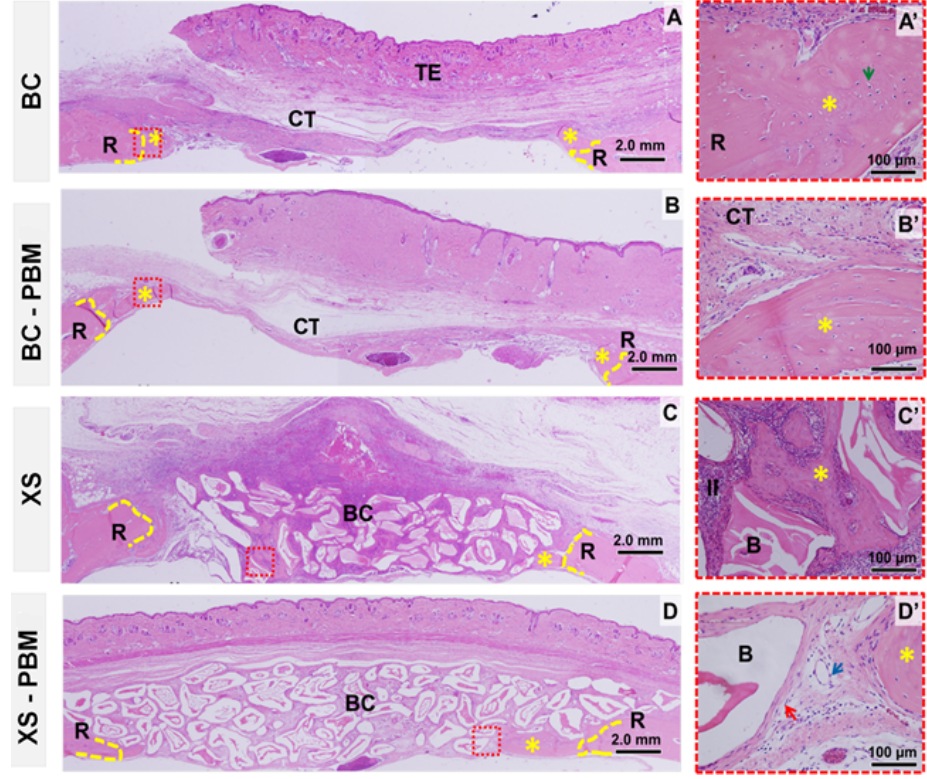
Figure 6. Histological images of critical size defects in rat calvaria within 42 days, coronal histological sections. (A) Blood clot group – BC; (B) blood clot with PBM group – BC-PBM; (C) xenogeneic bone graft + fibrin biopolymer scaffold group – XS; (D) xenogeneic bone graft + fibrin biopolymer scaffold with PBM group – XS-PBM. R: Remaining bone; TE: tegument; CT: connective tissue; BC: biocomplex biomaterial with fibrin biopolymer; B: Bio-Oss TM particle; II: inflammatory infiltrate. Dotted yellow line: border; asterisk: bone neoformation; red dotted square: highlighted area; green arrow: osteocyte; blue arrow: blood vessel; red arrow: concentric collagen fibers. HE staining. (A-D) 4x lens, bar = 2 mm. (A’-D’) enlarged 40× images, bar = 100